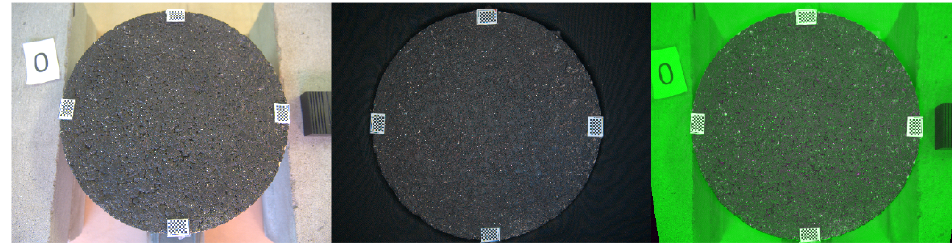
Figure 12. Triplet image. Left: 0th position in reference system. Centre: 0th position inside the box. Right: Overlapped after transformation Ref. Sys. →